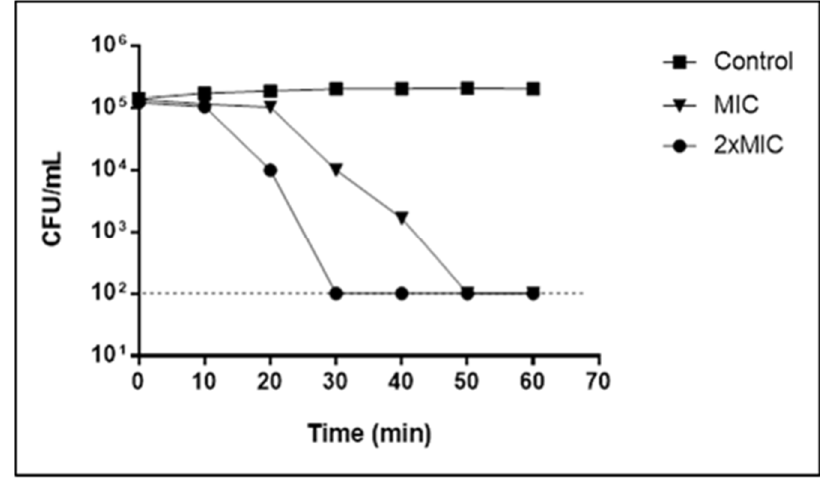
Figure 1. Time-kill curve for Staphylococcus aureus (LM-297) exposed to myrtenol at MIC and 2 × MIC concentrations.